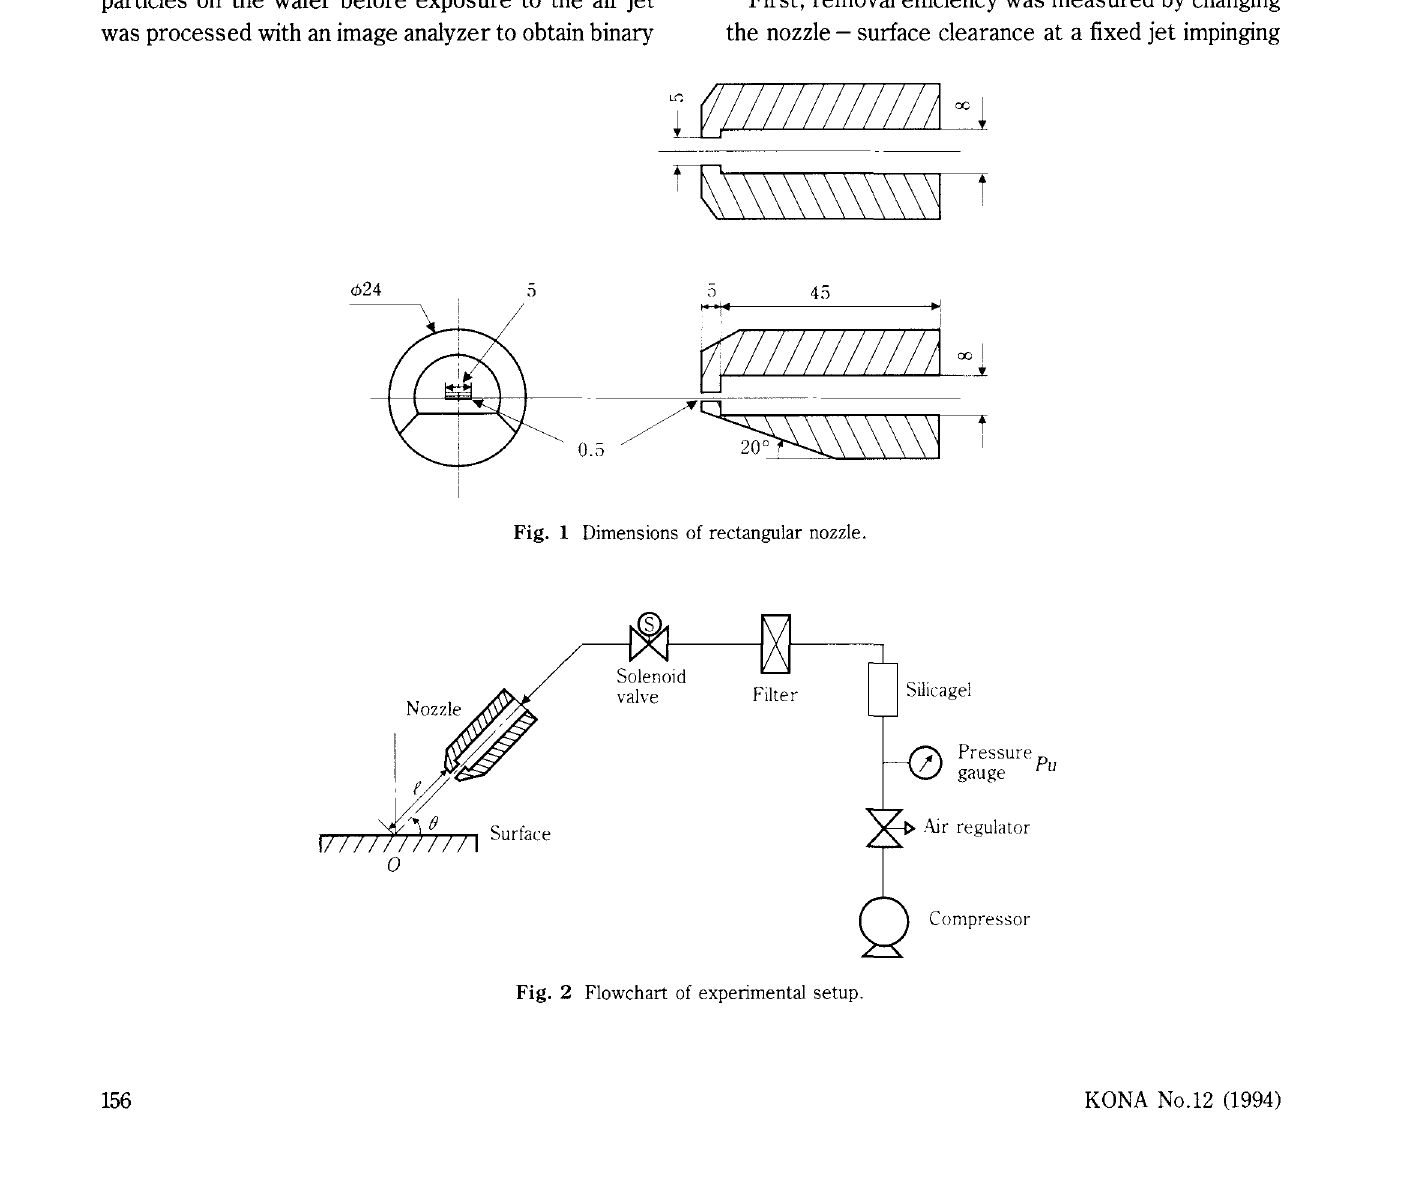
Fig. 1 Dimensions of rectangular nozzle.